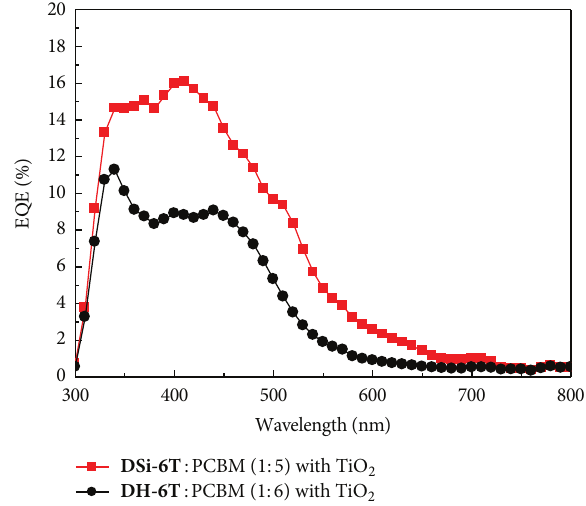
Figure 6: EQE curves of DSi-6T :PCBM (1:5) and DH-6T :PCBM (1:6) blend cells.